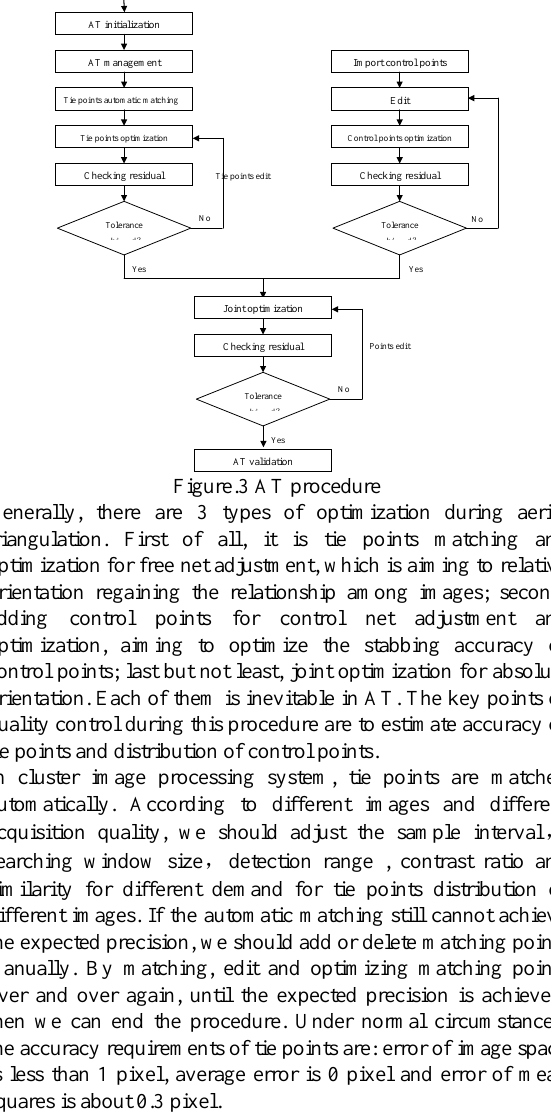
Figure 1. Frame of cluster remote sensing image processing system